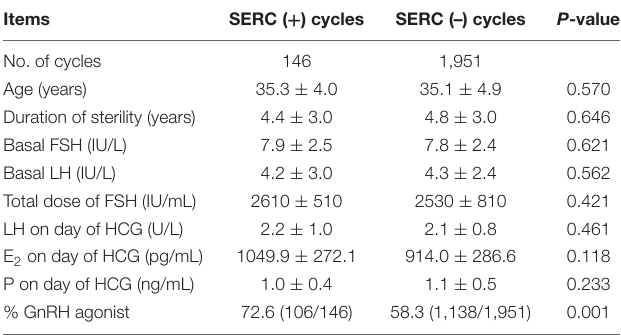
TABLE 1 | Patient characteristics in the SERC ( + ) and SER (–) cycle groups. TABLE 2 | Embryological, clinical, and neonatal outcomes in the SERC ( + ) and SER (–) cycle